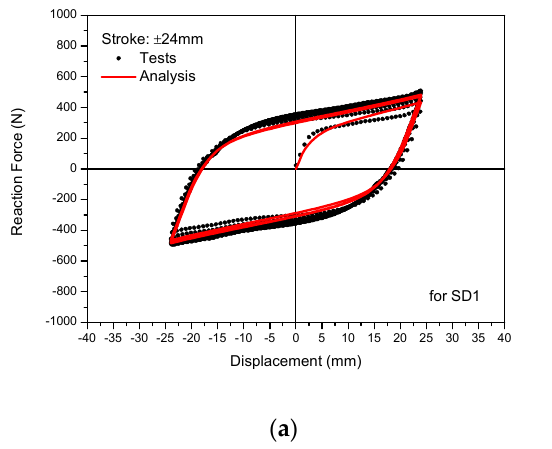
Figure 18. Comparison results of hysteretic behavior between tests and analyses for steel damper, SD1: ( a ) for ±24 mm stroke; ( b ) for ±30 mm stroke.